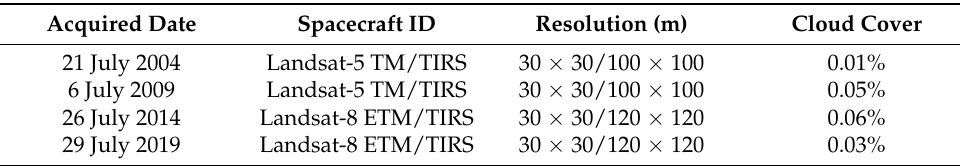
Table 1. Details of the Landsat data used in this study.